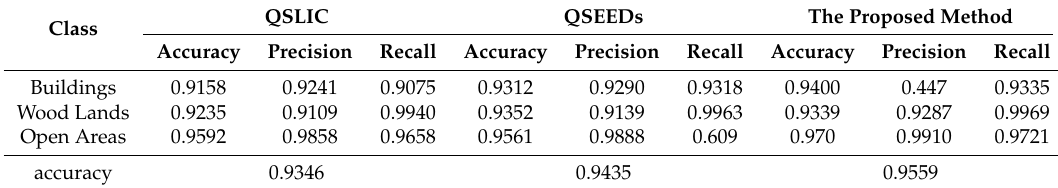
Table 3. The accuracy, precision and recall for Oberpfaffenhofen data set.